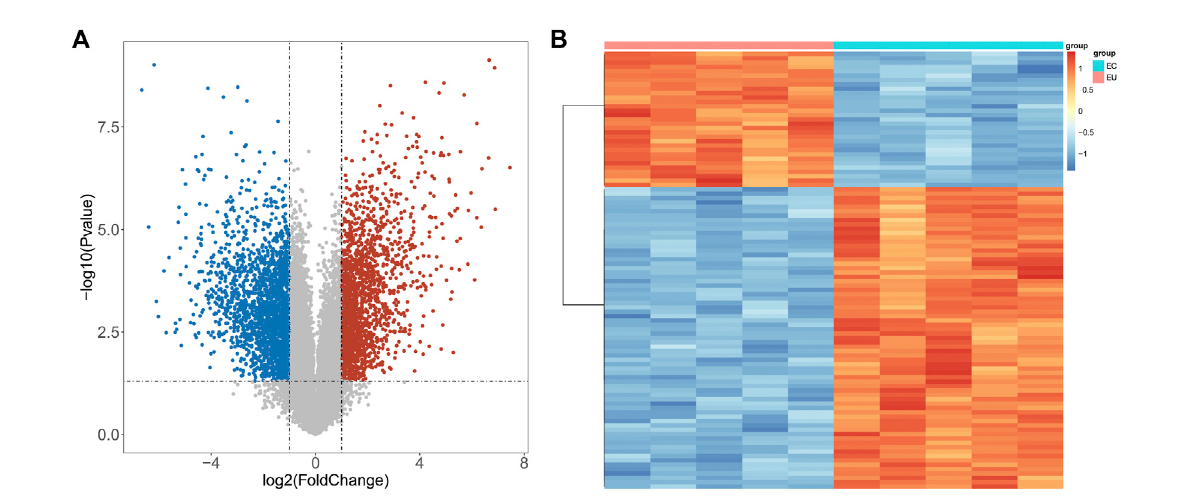
FIGURE 1 DEGs between EU and EC samples. (A) Volcano map of DEGs: The red dot indicates that the gene expression is upregulated, the blue dot indicates that the gene expression is down regulated, and the gray dot indicates that there is no signi fi cant difference between these genes. (B) Heat map of top100 DEGs: Each small square indicates each gene, and its color indicates the expression amount of the gene. The greater the expression amount, the darker the color (red indicates high expression and blue indicates low